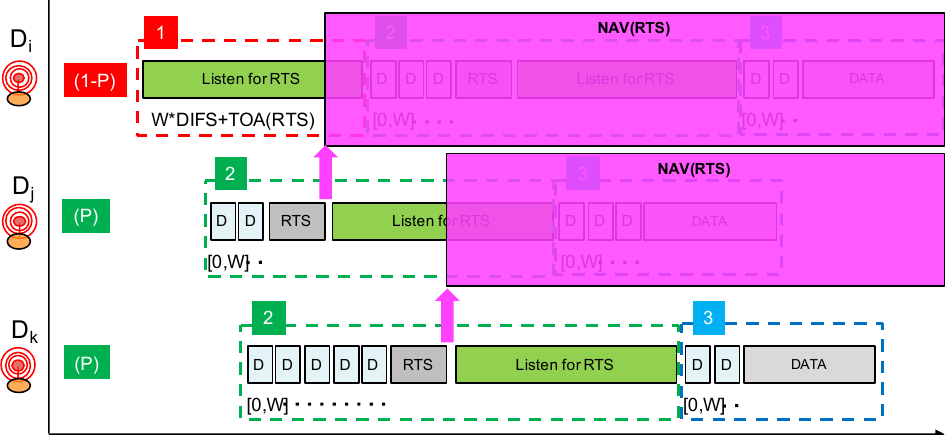
Figure 14. Using a network allocation